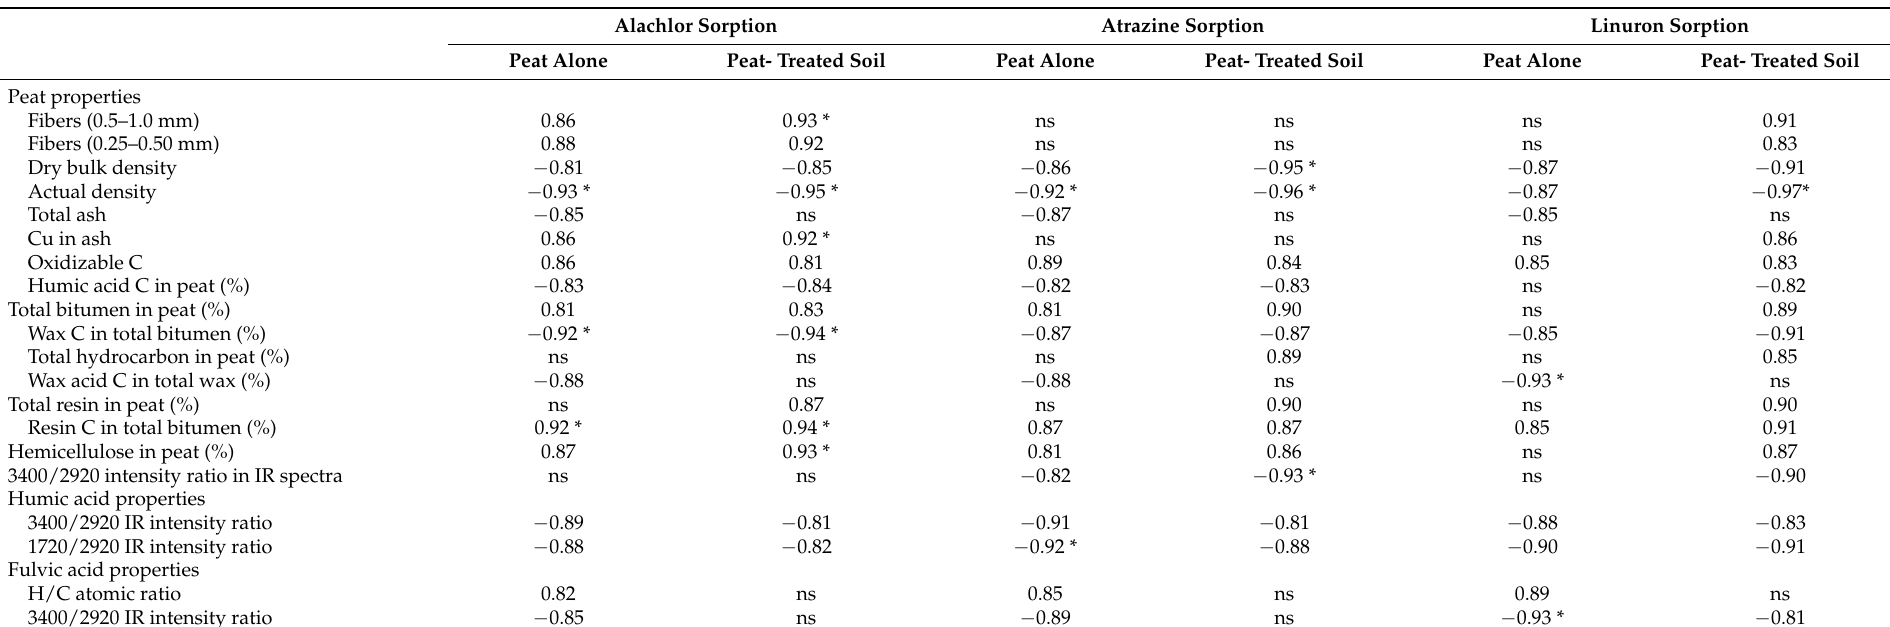
Table 5. Significant ( p < 0.05) correlation coefficients (Pearson product moment correlations) between physico-chemical characteristics of peat and the herbicide sorption in peat and peat-treated soil a .